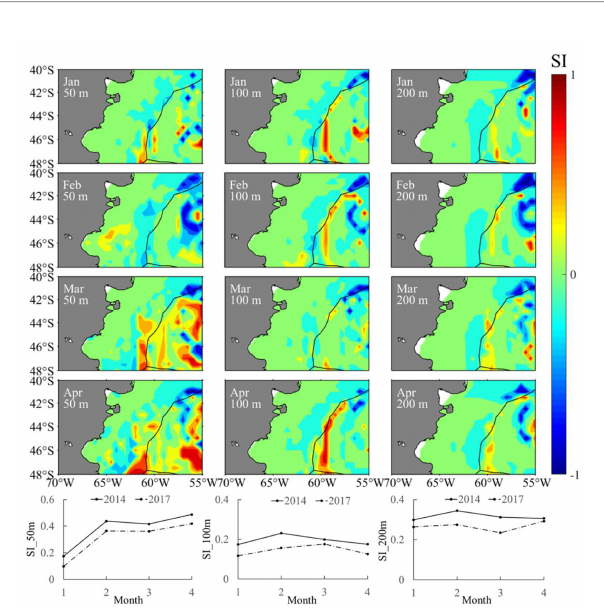
FIGURE 9 | Spatial and temporal difference in suitability index of sea water temperature (the upper panel) and average suitability index of sea water temperature (lower panel) from January to April between 2014 and 2017 at depths of 50, 100, and 200 m in the Southwest Atlantic